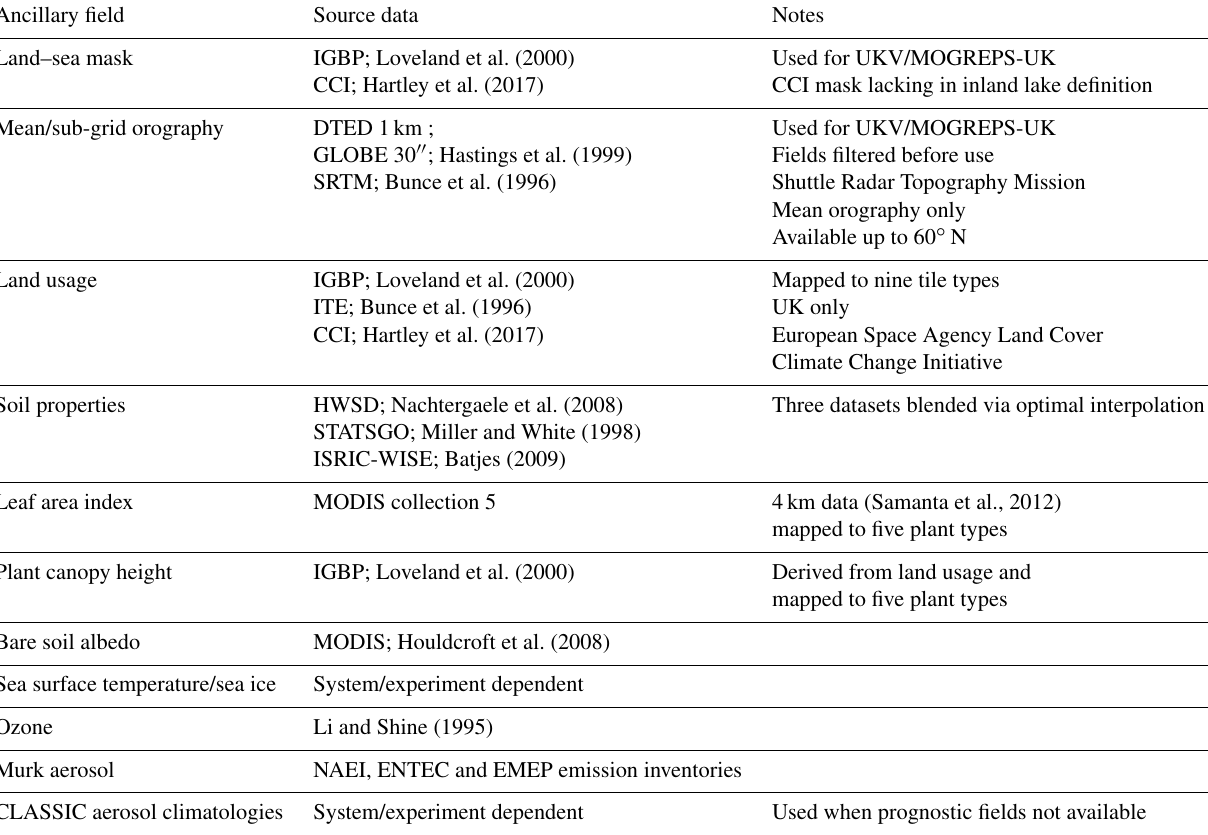
Table A1. Source datasets used to create standard ancillary files used in